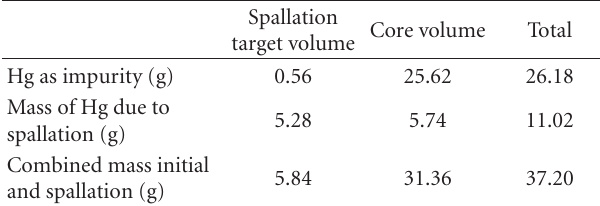
Table 5: Origin of mercury in the LBE at the end of 90-day irra- diation